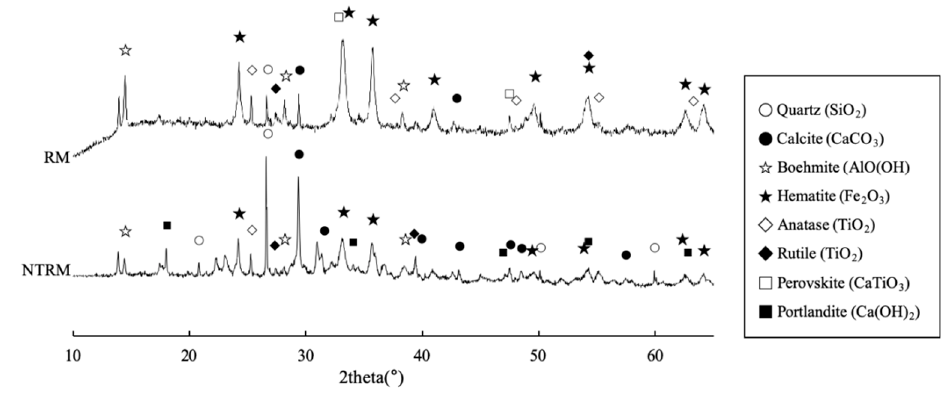
Figure 3. XRD patterns of RM and NTRM.